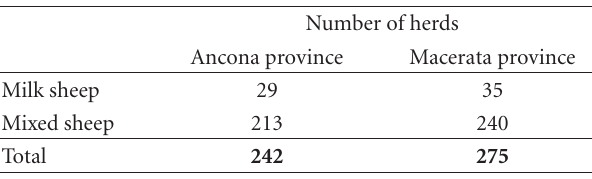
Table 1: Number of herd consistence recorded by Italian